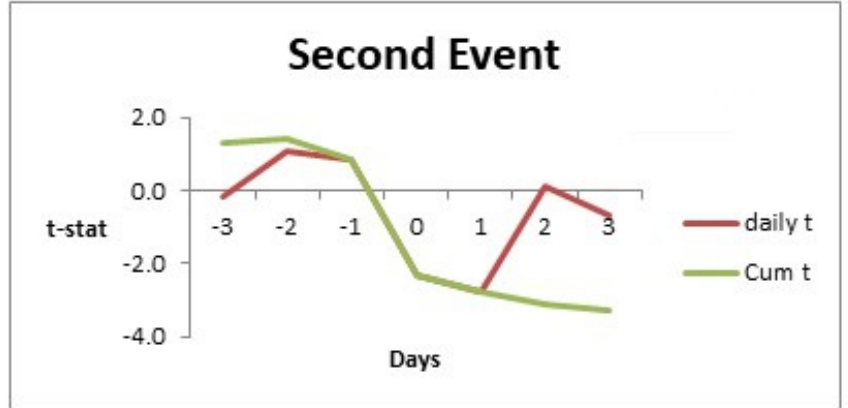
Figure 8. Daily t for AAR and cumulative t for CAAR. Source: Authors’ work.